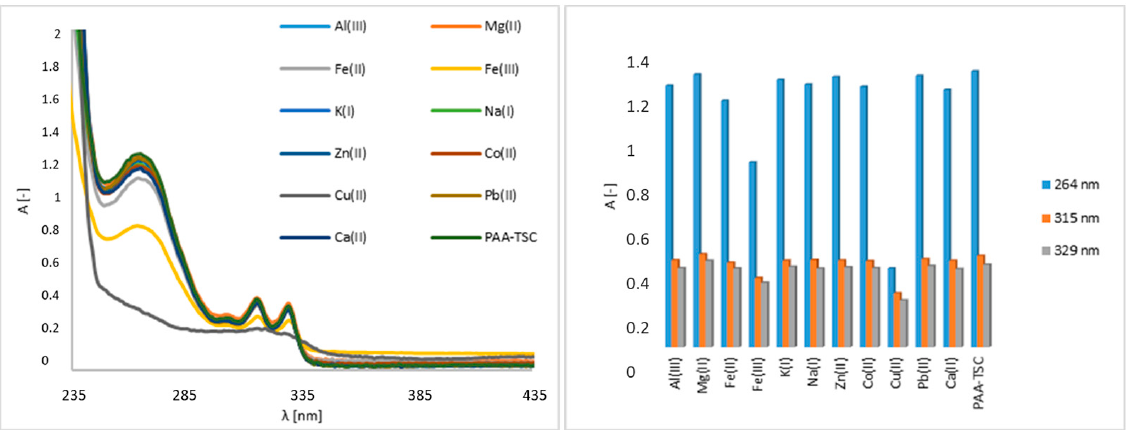
Figure 1. UV ‒ Vis spectra of the PAA-TSC receptor (100 μ M) without and with metal ions (5000 μ M) in water (water/DMSO, 99:1, v / v ), including a bar graph of the absorption maxima (264 nm, 315 nm, 329 nm).